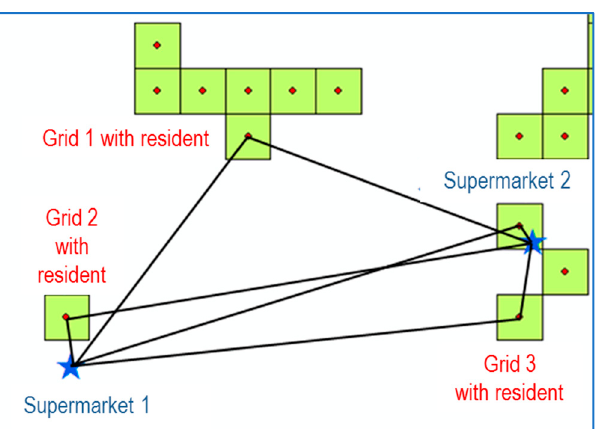
Figure 2. Measurement of the distance from the center of grid with residents to the nearest grocery store (supermarket).